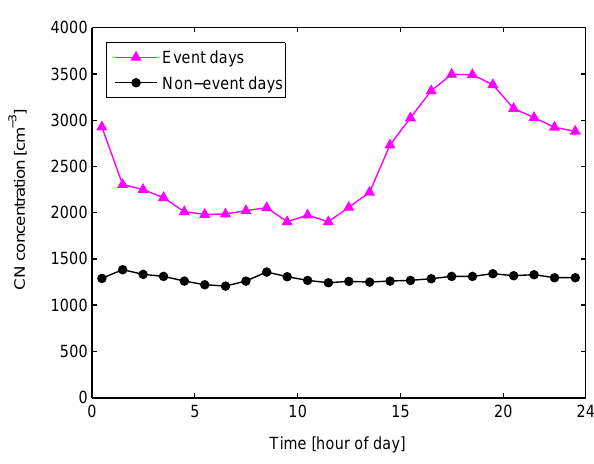
Fig. A1. Mean total particle number concentration (CN, diameter range 3–1000nm) on event and non-event days at Hyyti¨al¨a SMEAR II